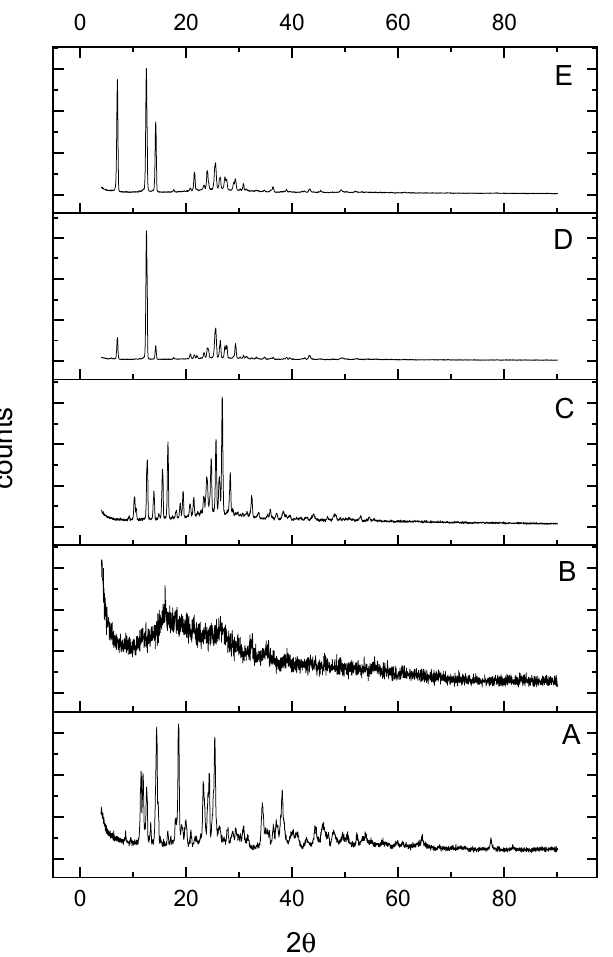
Figure 4. X-ray powder diffraction patterns of ( A ): pipH, ( B ): Mg(II), ( C ): Ca(II), ( D ): Zn(II), and ( E ): Fe(III)–pip complexes.